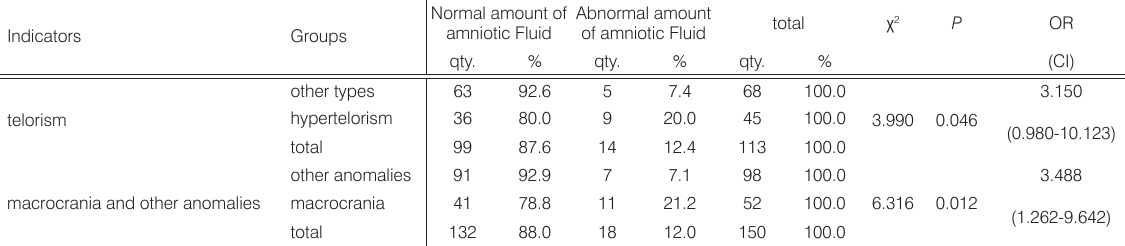
Table 3. Amniotic fluid - quantitative changes and associated anomalies in fetuses with NTDs.